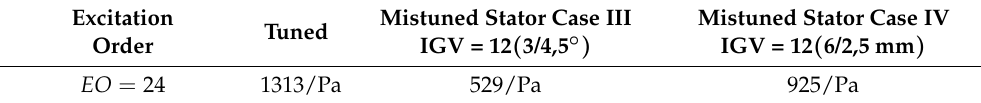
Table 6. Comparison of the excitation force amplitudes of three stator